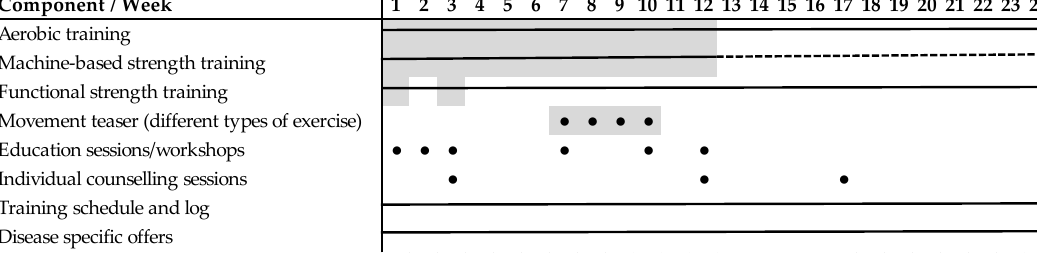
Figure 2. ‘Multipill-Exercise’ intervention components. Greyed: supervised exercise sessions. Dotted lines: optional. Dots display the special intervention components respective to the week they took place.